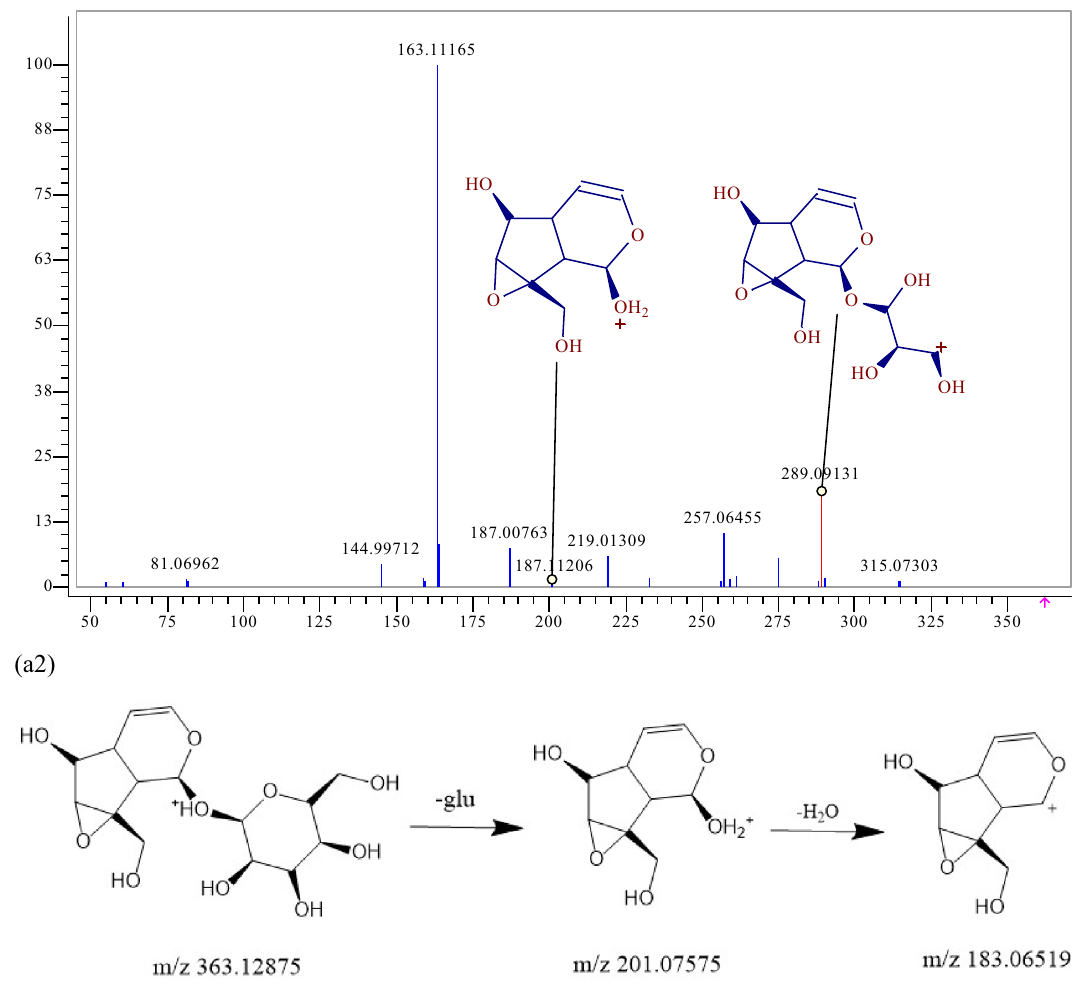
Figure 6. MS 2 spectra and the cracking diagram of